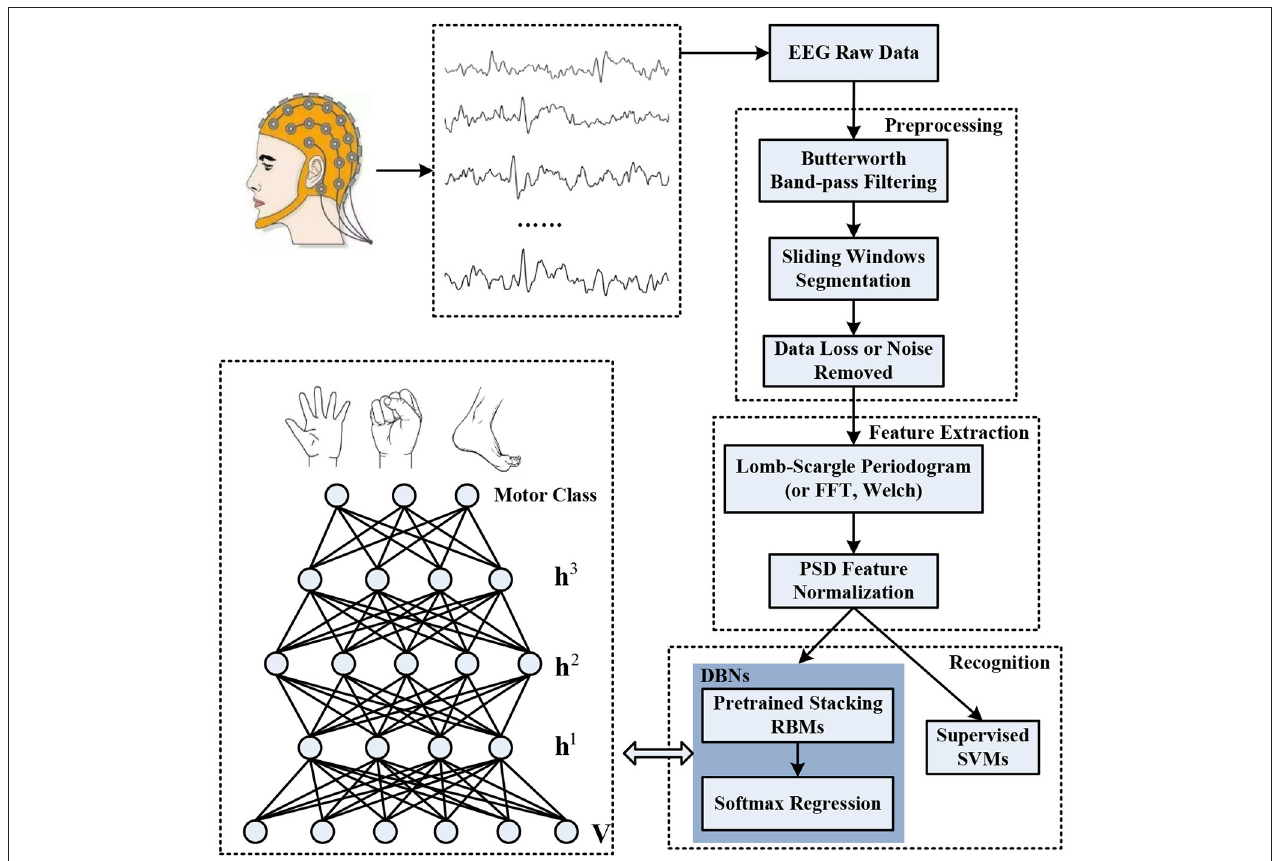
FIGURE 1 | The overall decoding scheme for incomplete motor imagery EEG signals based on deep belief network (DBN).